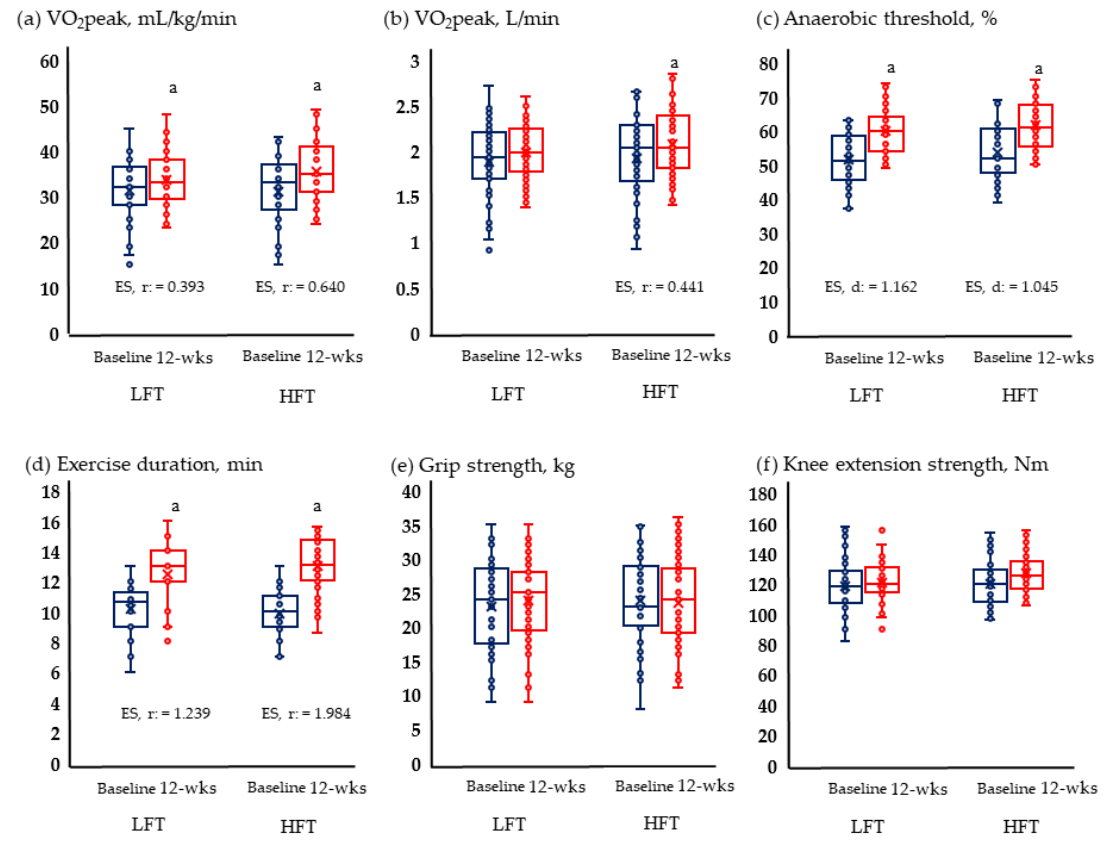
Figure 2. Change in physical fitness; ( a ) Change of relative VO 2 peak; ( b ) change of absolute VO 2 peak; ( c ) change of anaerobic threshold; ( d ) change of exercise duration; ( e ) change of grip strength; and ( f ) change of knee extension strength in LFT and HFT groups according to 12 weeks intervention. p < 0.05; a, Baseline vs. 12 wks; wks, weeks; LFT, low-frequency training; HFT, high-frequency training; ES, effect size. Blue boxplots are baselines corresponding to pre-intervention, and red boxplots are 12-wks post-interventions.